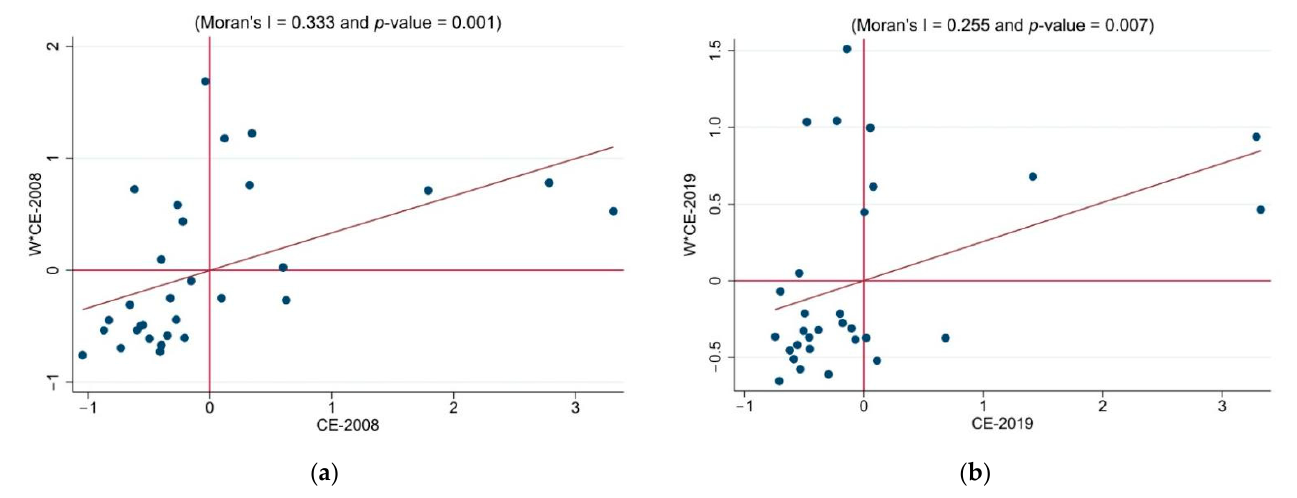
Figure 1. Moran’s I scatter plot of carbon emissions in 2008 ( a ) and 2019 ( b